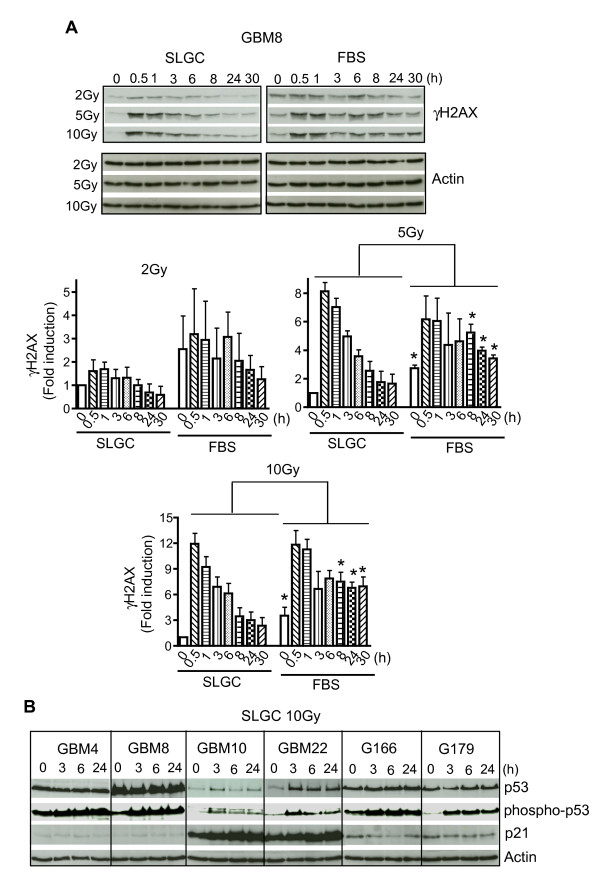
Kinetics of expression of γIR-induced DNA damage response proteins. SLGCs and directly derived FBS cultures were irradiated with the doses indicated. A. Expression levels of phosphorylated histone H2AX (γH2AX) detected by Western blot (representative result, upper panel) and quantification of γH2AX-signals using Image Quant TL (lower panels). B. Expression levels of p53 and its target gene p21 (WAF1/Cip1), as well as of phosphorylated p53 in cell lysates collected at the indicated times after irradiation. Actin levels are shown as control. In A and B, blots shown are representative of three independent experiments.